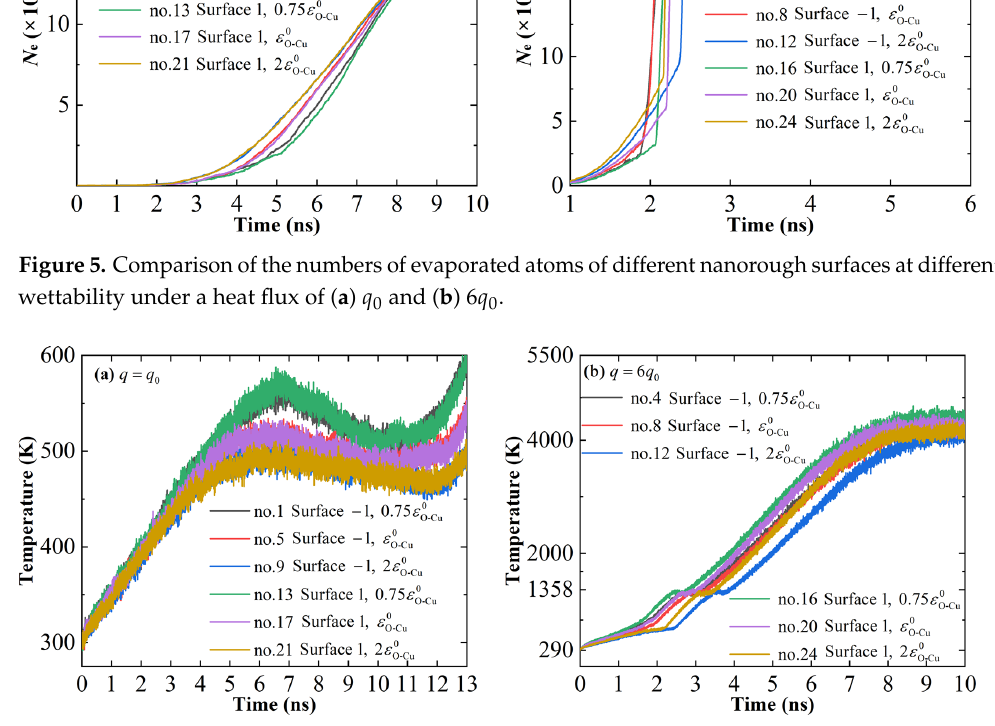
Figure 6. Comparison of the bottom plate temperature of different nanorough surfaces at different wettability under a heat flux of ( a ) q 0 and ( b ) 6 q 0